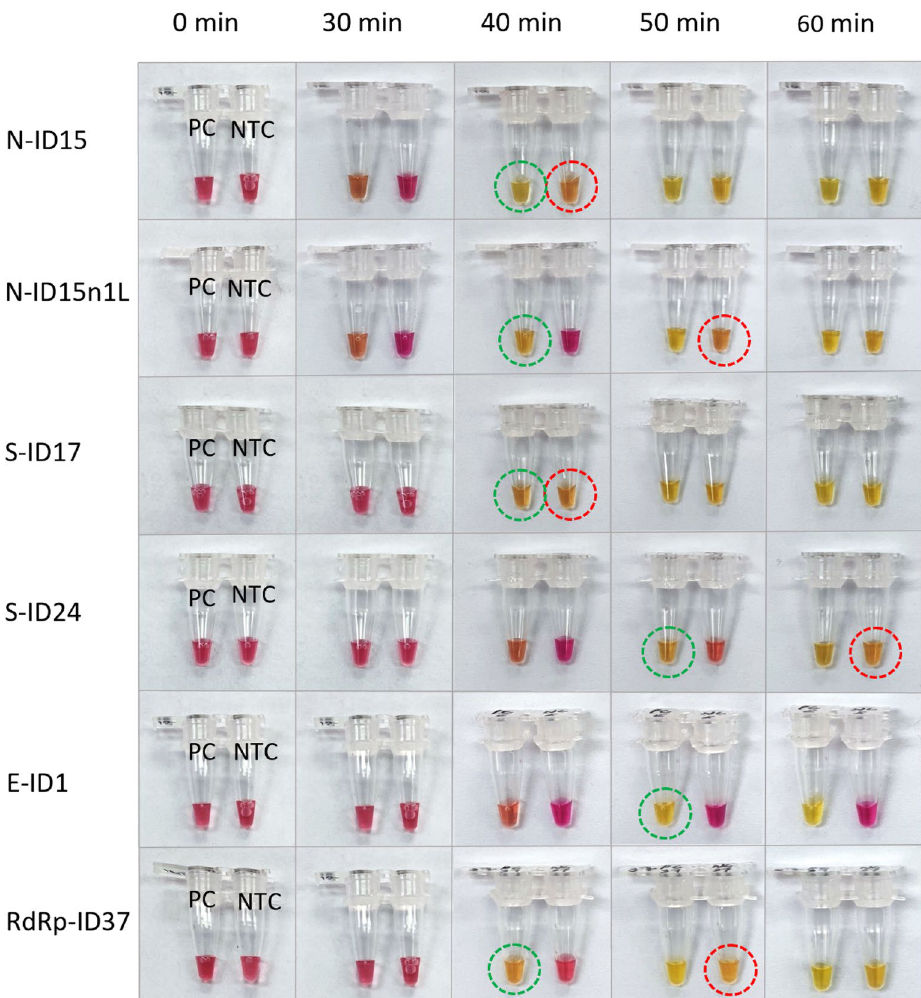
Figure 1. Colorimetric test using all primer sets on positive controls (PC) and non-template controls (NTC). A visible color change from red to yellow develops in PC tubes in the colorimetric identification, and negatives remain red. The color development was observed before (0 min) and after the reaction (between 30 and 60 min). The green circle denotes the earliest color development in the PC reaction tubes. The red circles represent the NTC reactions that led to the earliest